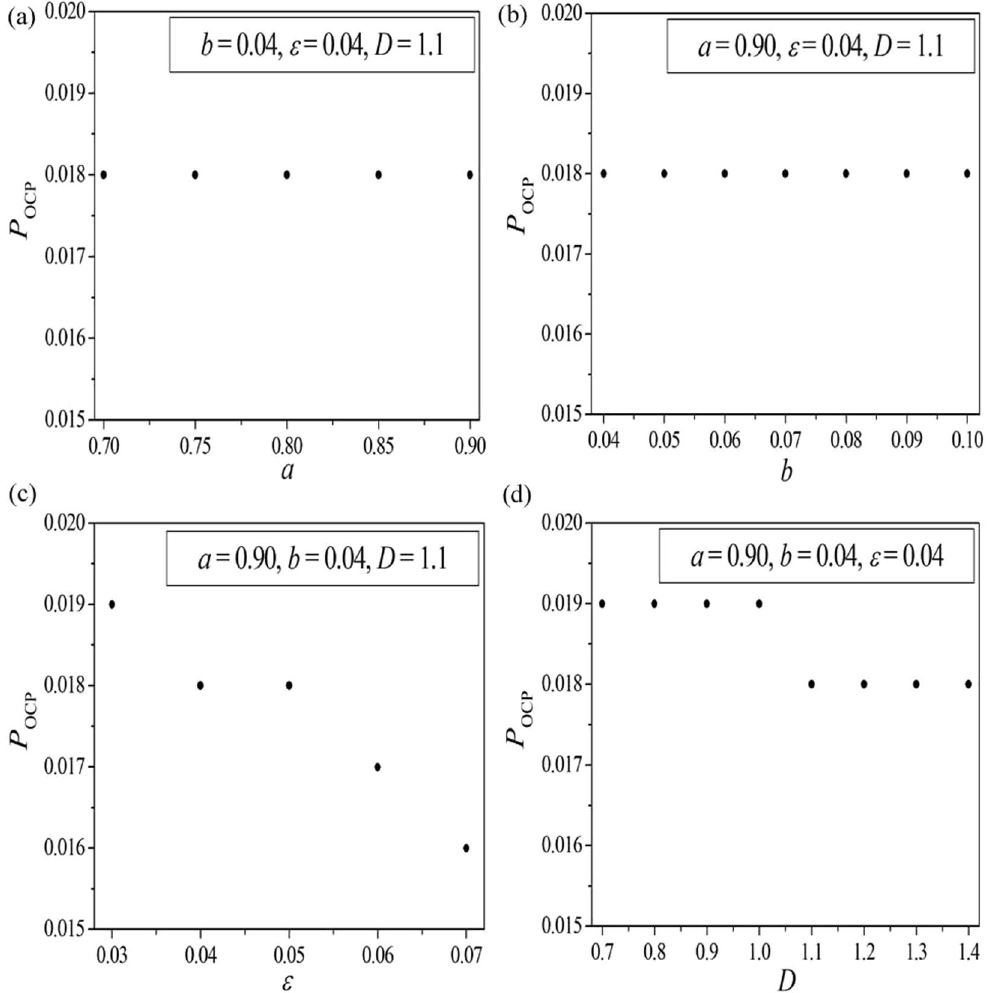
Figure 2. The relationship between the optimal connection probability P OCP and the system parameters a ( a ), b ( b ), ε ( c ) and D ( d ). Other parameters are fixed and marked in the corresponding